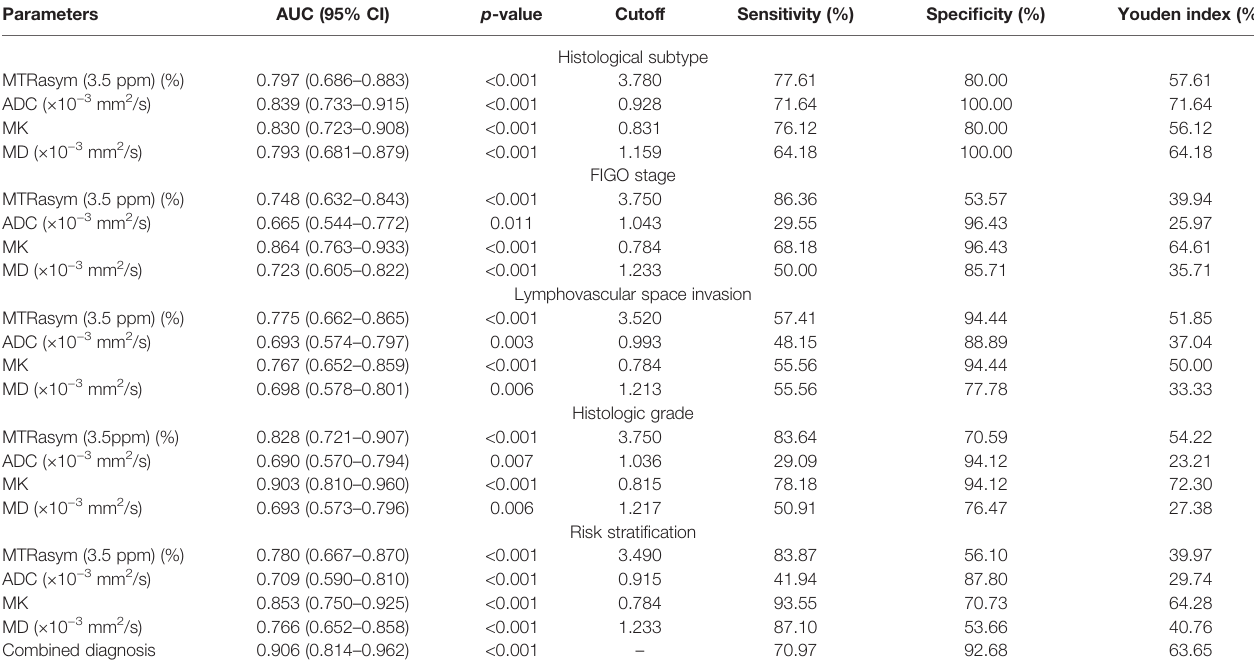
TABLE 4 | Predictive performance of the different